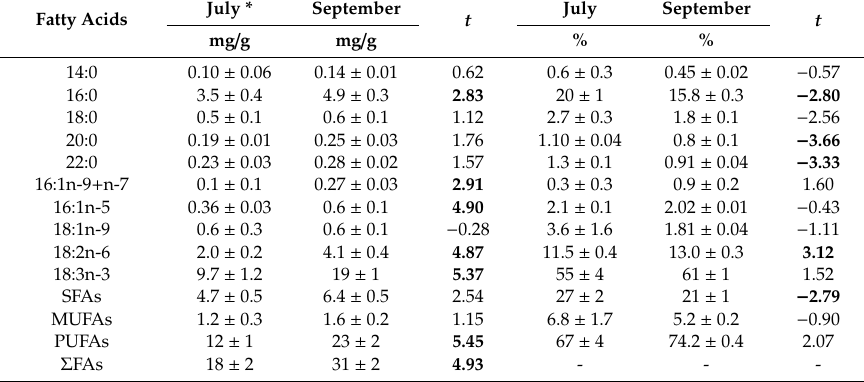
fatty acids, SFAs—saturated fatty acids, MUFAs—monounsaturated fatty acids, PUFAs—polyunsaturated fatty acids, bold font—significant di ff erences according to Student’s t